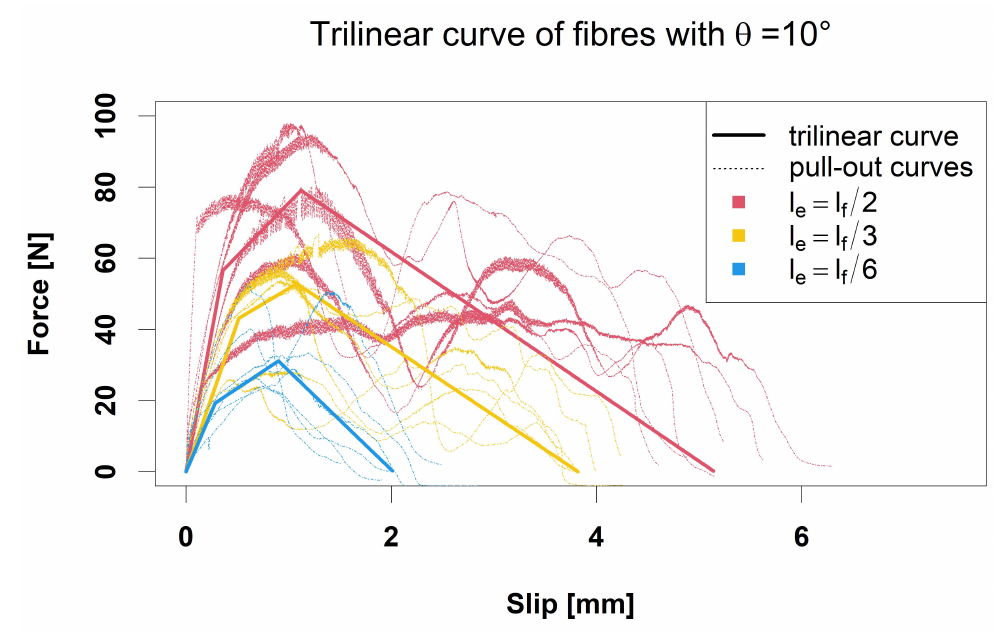
Figure 3. Trilinear curves (solid) of the single-fibre pull-out force curves (dotted) with angle θ = 10 ◦ and embedded lengths l e = l f /2, l e = l f /3, l e = l f